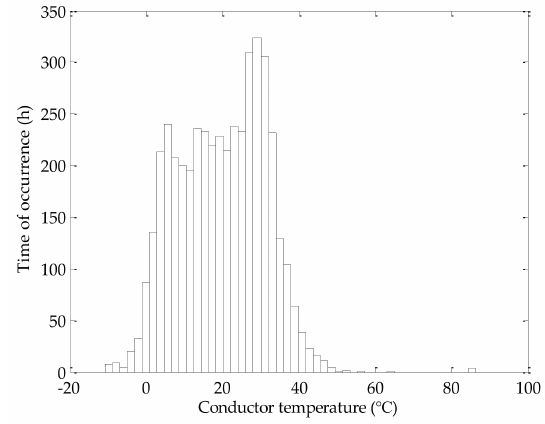
Figure 1. Time of occurrence of conductor